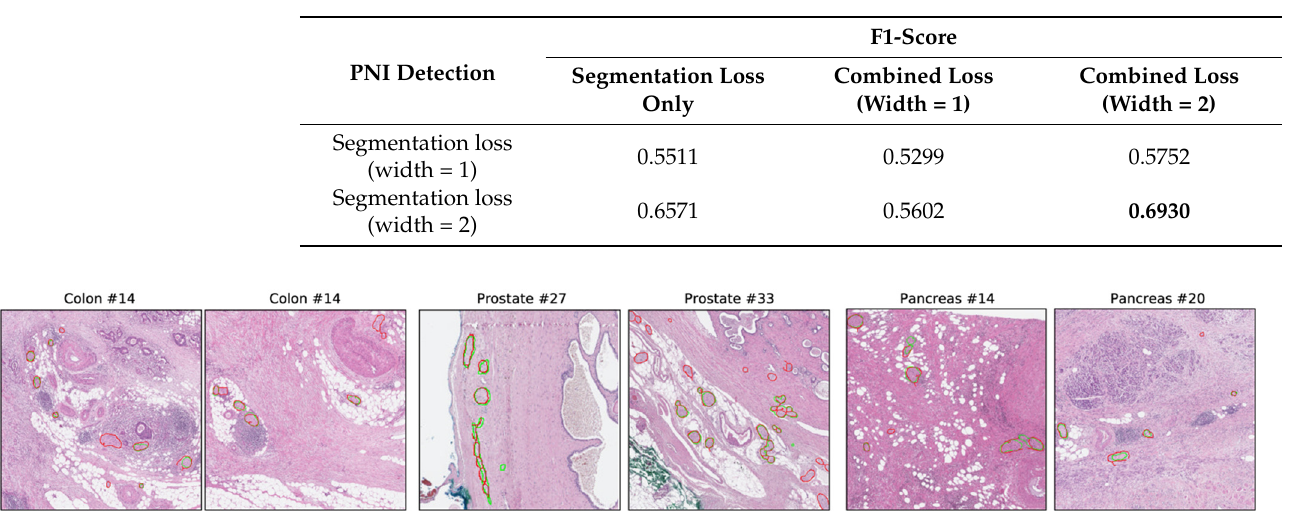
Table 2. Average F1-score on test sets for nerve detection.